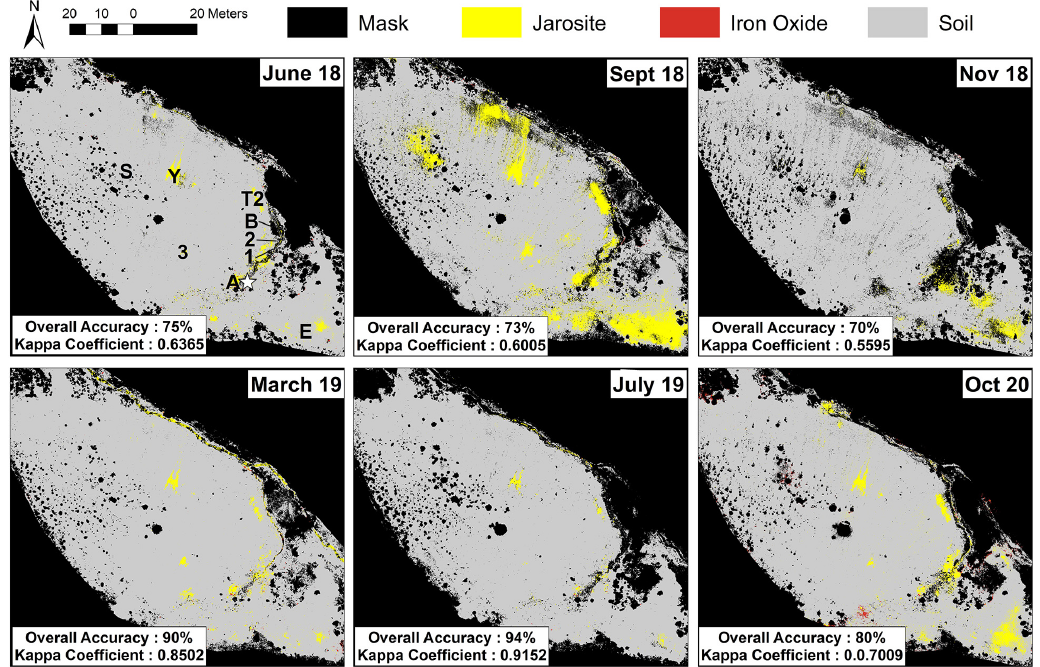
Figure 7. Results of Spectral Angle Mapper Classification for each remotely piloted aerial system survey. Overall Accuracy for all six surveys is 80%, with a Kappa Coefficient of 0.7104. Locations for ground surveys are indicated on the June 2018 map for Y, T2, B, A, E, S, and Transects 1–3 (1,2,3), and the adit drain is indicated with a star. Each scene is 134 m wide and 118 m